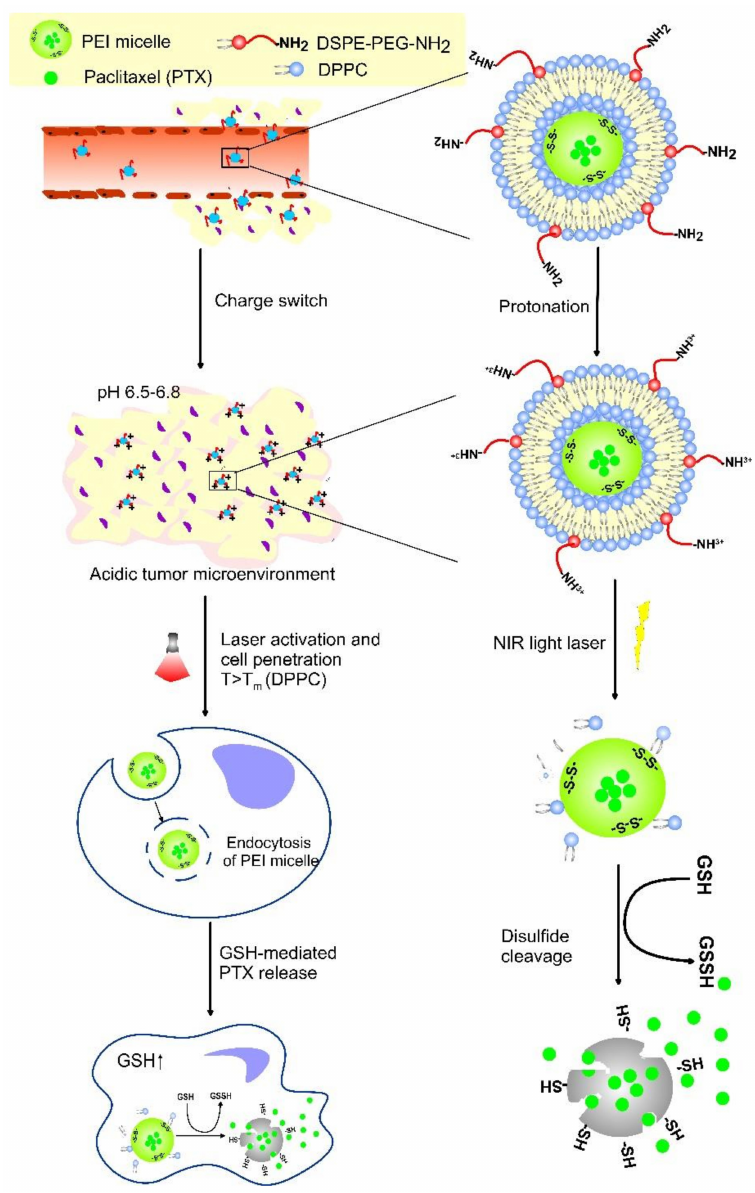
Figure 14. A schematic mechanism of the hierarchical activation strategy of pH, temperature, and GSH-sensitive liposomes for delivery of PTX in cancer